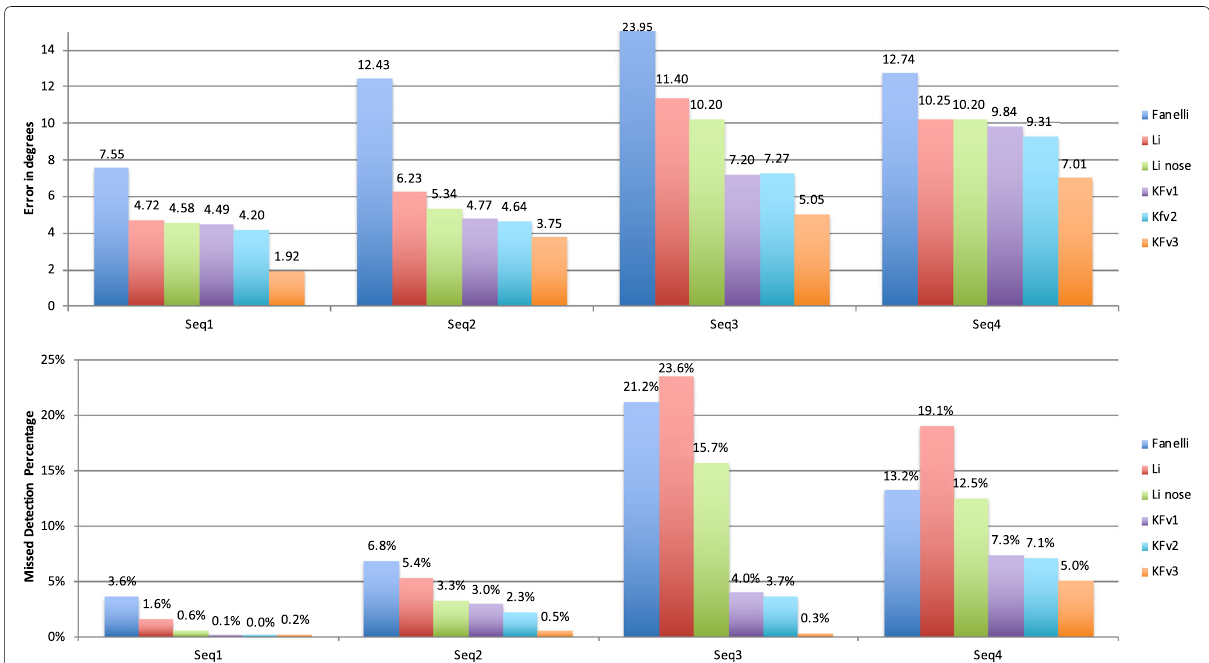
Fig. 14 Results of ICU sequences using (blue) Fanelli, (red) Li’s simple approach, (green) Li’s proposal including of nose detection heuristic, and (purple) our descriptor-based method without and with optimization (cyan). The first row shows the mean angular error, and the second the missed detection. For clarity, each graphic only shows two sequences